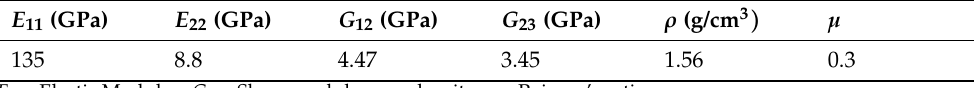
Figure 2. Wing tank low velocity impact monitoring system based on fiber Bragg grating sensor. Table 1. Composite T300/QY8911 material parameters [23].